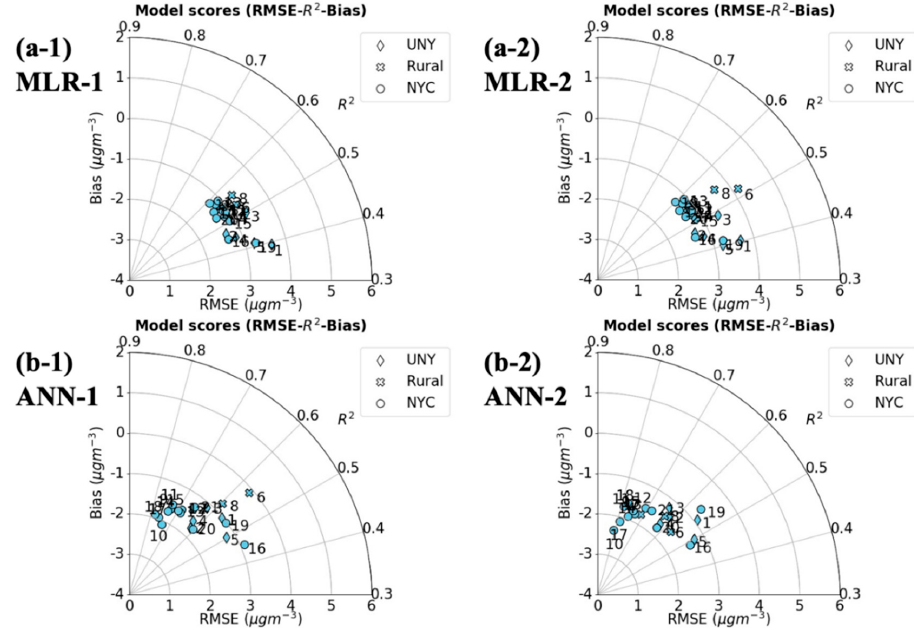
Figure 2. Statistical scores of the testing results of the ( a-1 , a-2 ) MLR and ( b-1 , b-2 ) ANN models with (1) set 1 and (2) set 2 predictors. Site labels are referred from Table 2. Diamonds, crosses and circles are UNY, rural and NYC sites,